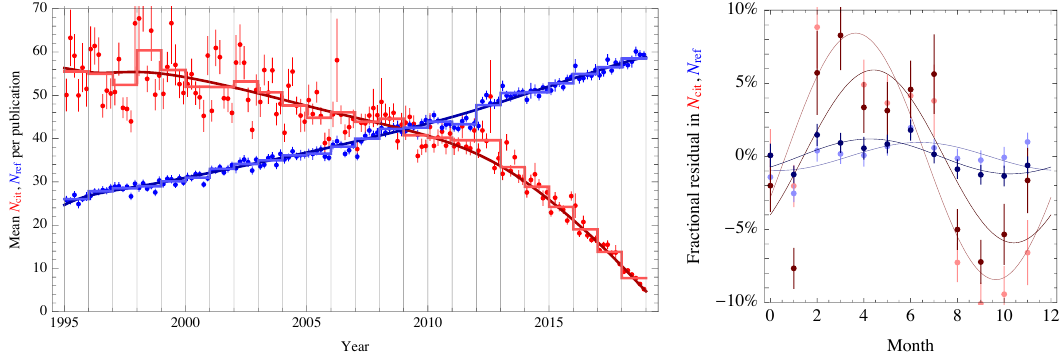
Figure 1 . Left: average number of citations N cit (red) and of references N ref (blue) of publications in high-energy physics in arXiv as function of time. Both show an annual modulation together with a trend on a slower, decennial, time-scale: N cit is decreasing and N ref is growing (smooth curves). Right: monthly variation computed integrating over the years and subtracting the slow trend in two di(cid:11)erent ways: subtracting the discontinuous yearly averages (lighter red and blue) or their smooth averages (darker red and